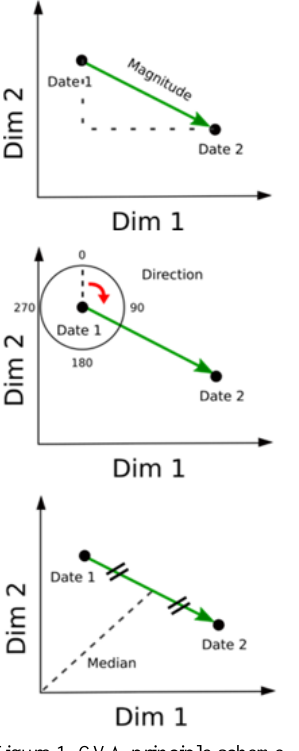
Figure 1. CVA principle scheme.